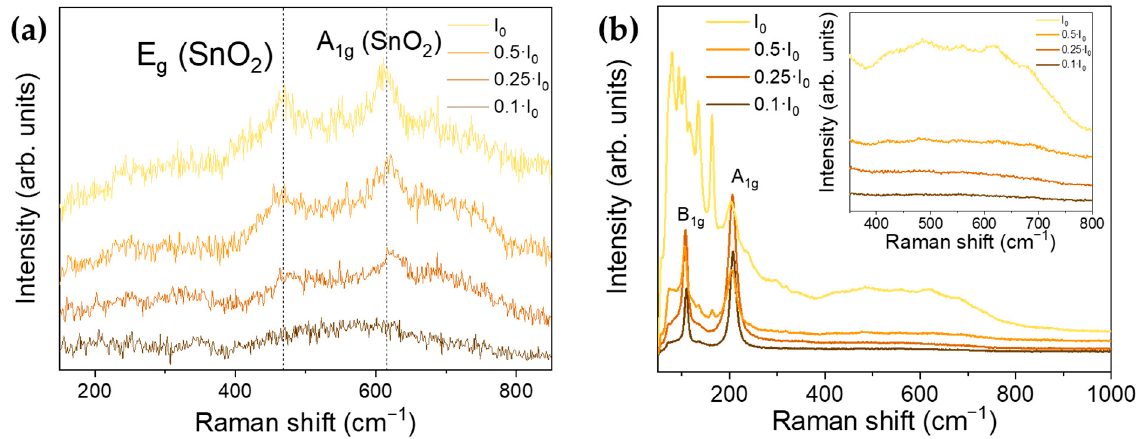
Figure 3. Raman spectra of the SnO sample with different energy density irradiations obtained with ( a ) UV laser ( λ = 325 nm) or a ( b ) red laser ( λ = 633 nm). Inset in ( b ) shows zoomed the region between 375–800 cm − 1 .